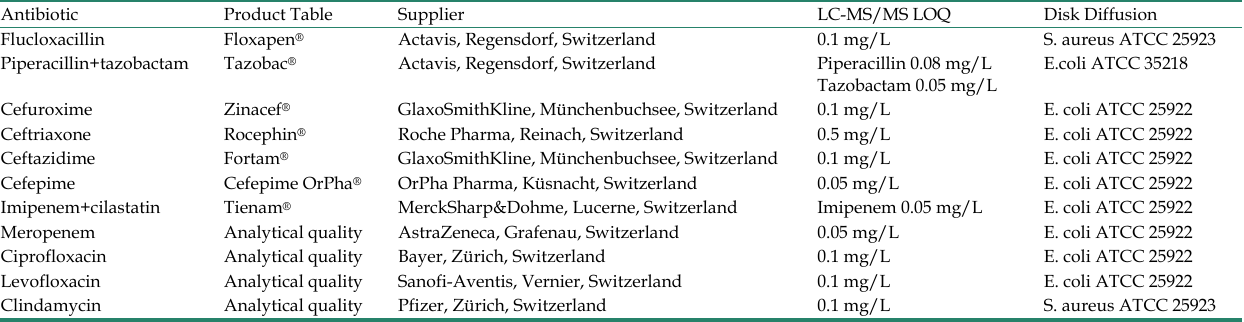
Table 1 . List of antibiotics used in the experiments. The lower limit of quantification (LOQ) of the LC-MS/MS assay used is listed. The reference bacterium used for disc diffusion assays is also included.